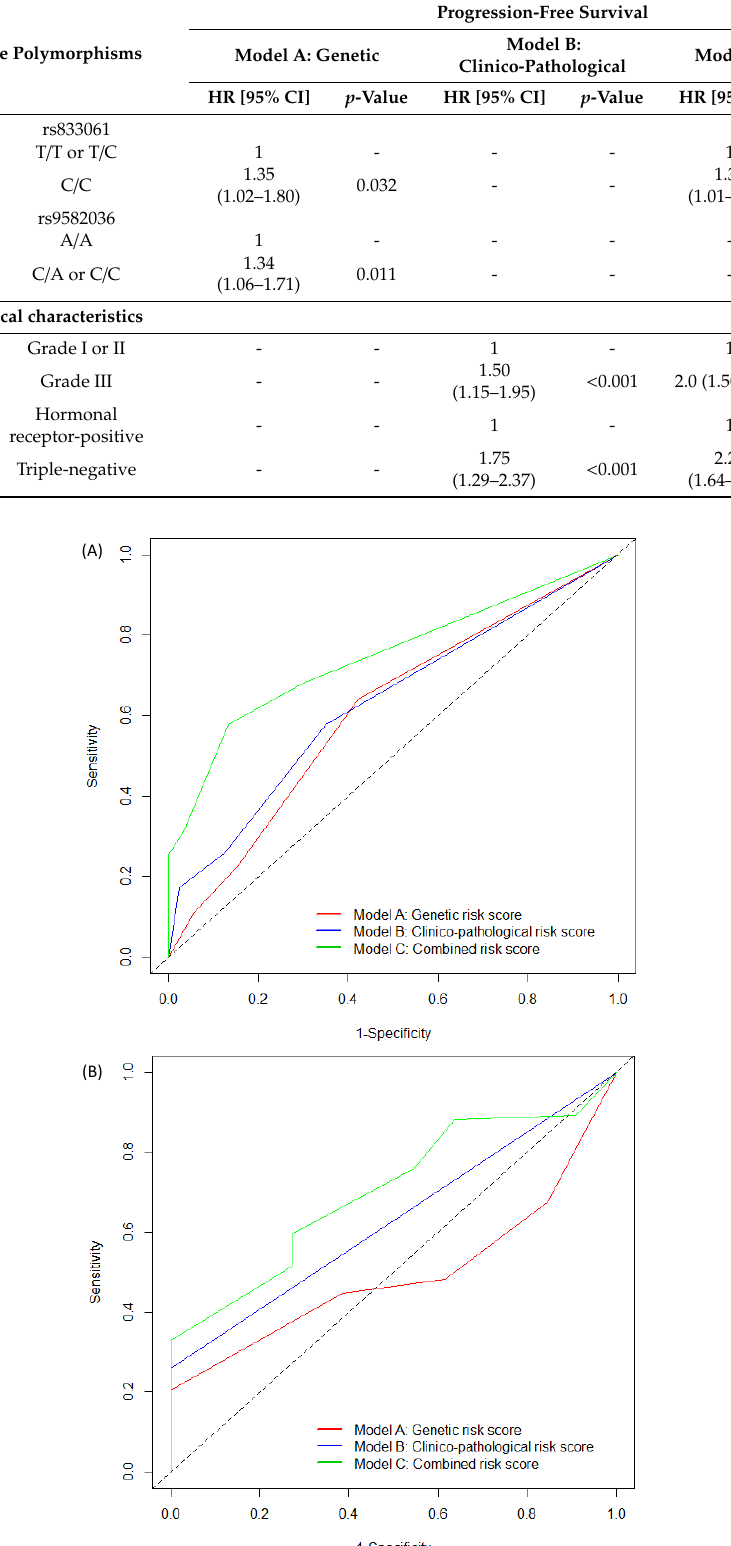
Figure 2. Receiver operating characteristic (ROC) curves and AUC for risk scores for three models. ( A ) PFS at 24 months; ( B ) OS at 60